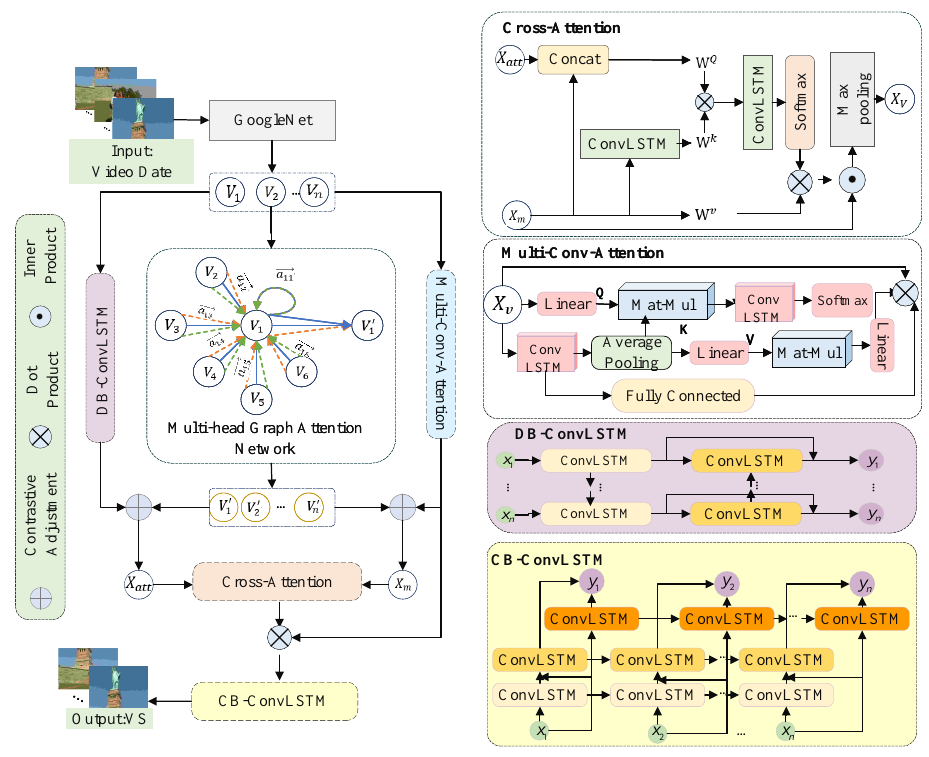
Figure 1. Overview of our